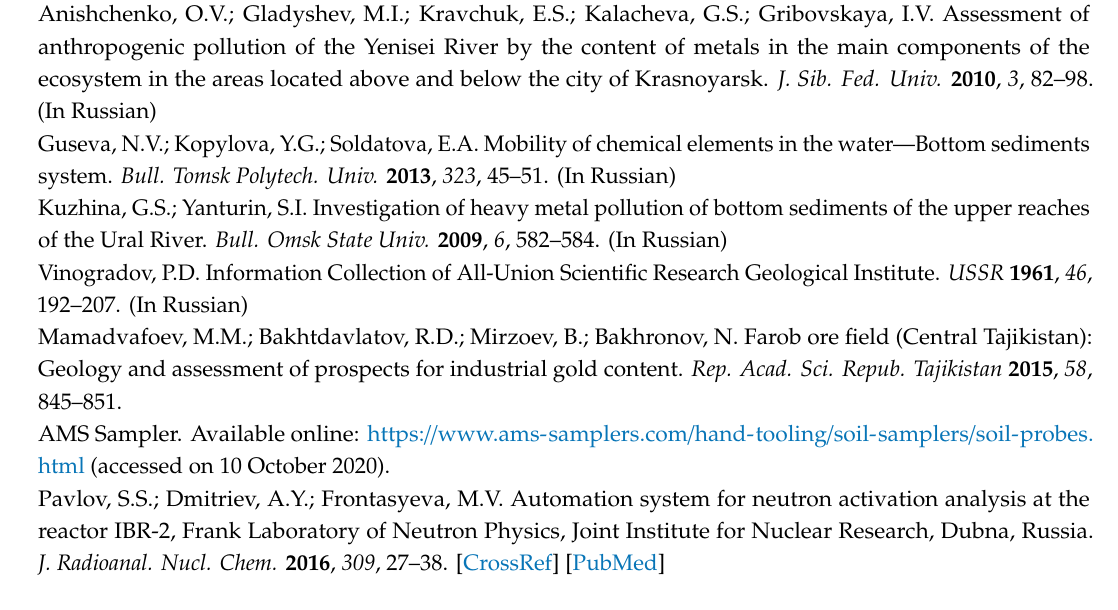
Table S1: The values of contamination factor of soils (i) and sediments (h); Table S2: The values of geoaccumulation index of soils (i) and sediments